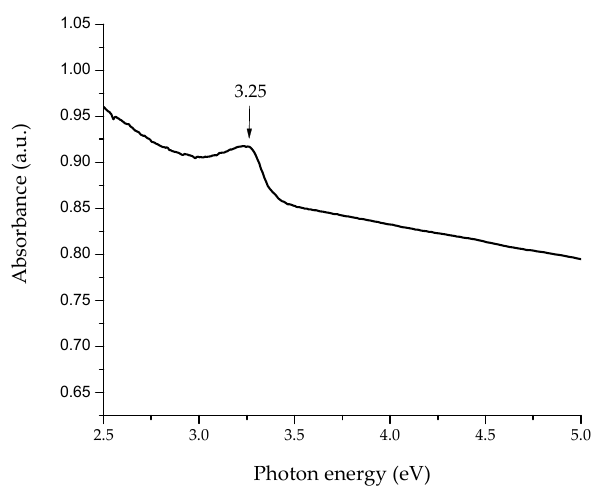
Figure 1. UV–vis absorption spectrum of synthesized flower-shaped zinc oxide (ZnO) nanostructures.